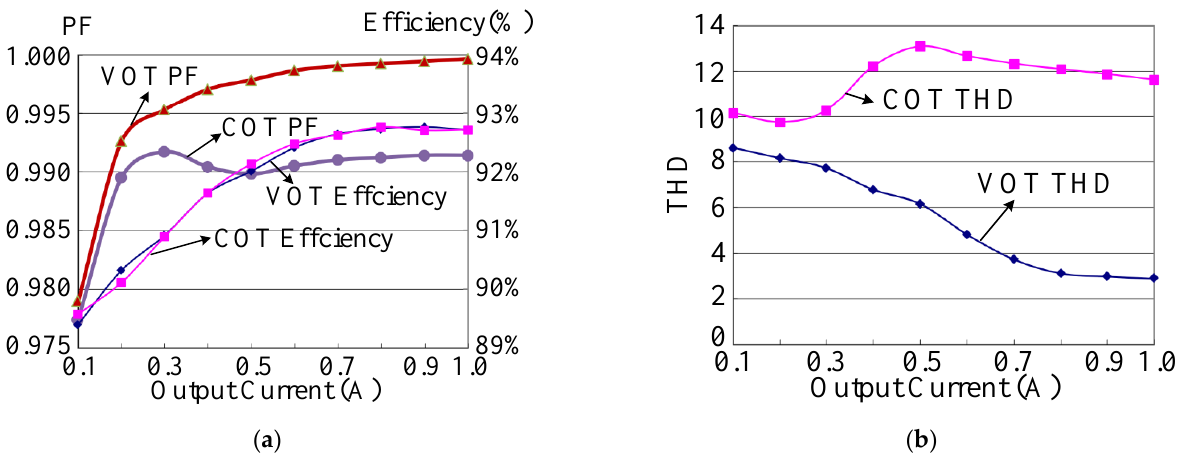
Figure 27. Experimental comparison of PF, Efficiency, and THD data with 0.1~1 A output current and 110 Vac input voltage. ( a ) PF and efficiency; ( b ) THD.